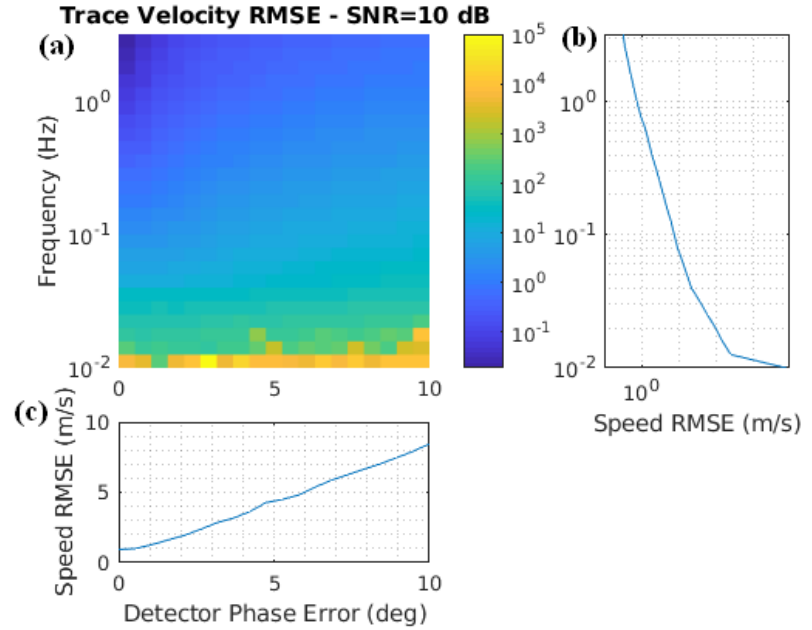
Figure 22. The same as Figure 20 but with an SNR of 10 dB. ( a ) RMSE for a case with no noise, and a consistency threshold of 0.1 s, as a function of frequency and sensor phase error, ( b ) median RMSE over all sensor phase errors, ( c ) median RMSE over all